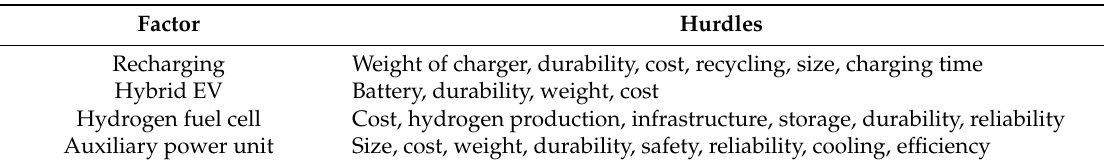
Table 29. Hurdles in key EV factors. Adapted from